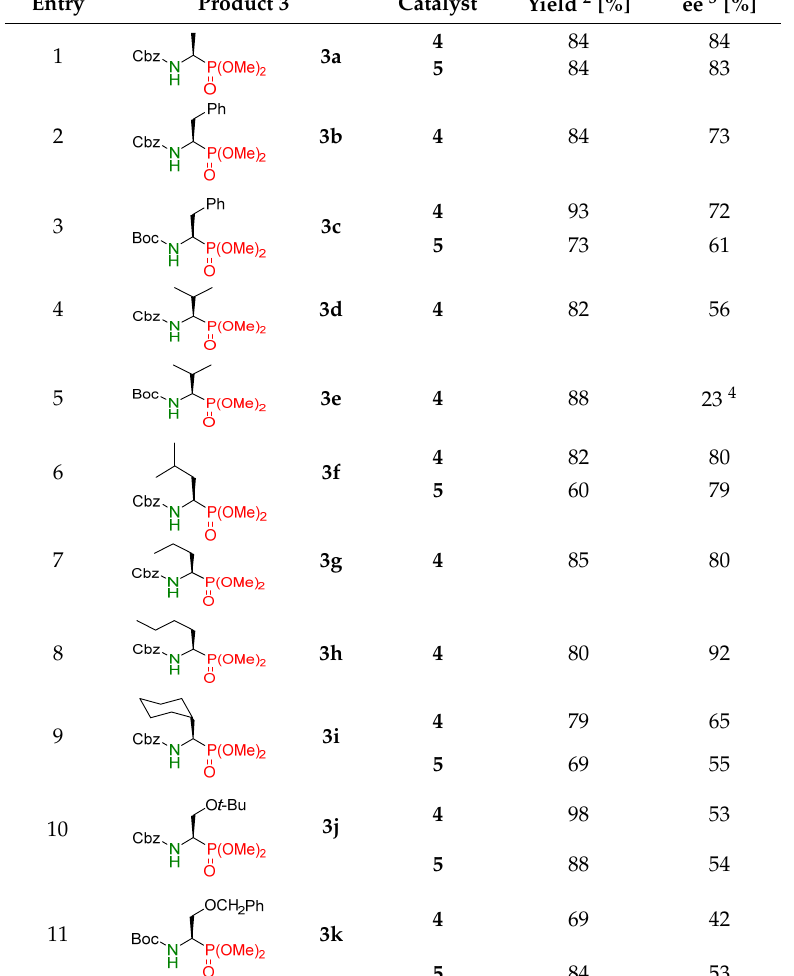
Table 2. Substrate scope of the stereoselective reaction of phosphonium salts 2 with dimethyl phosphite. 1.